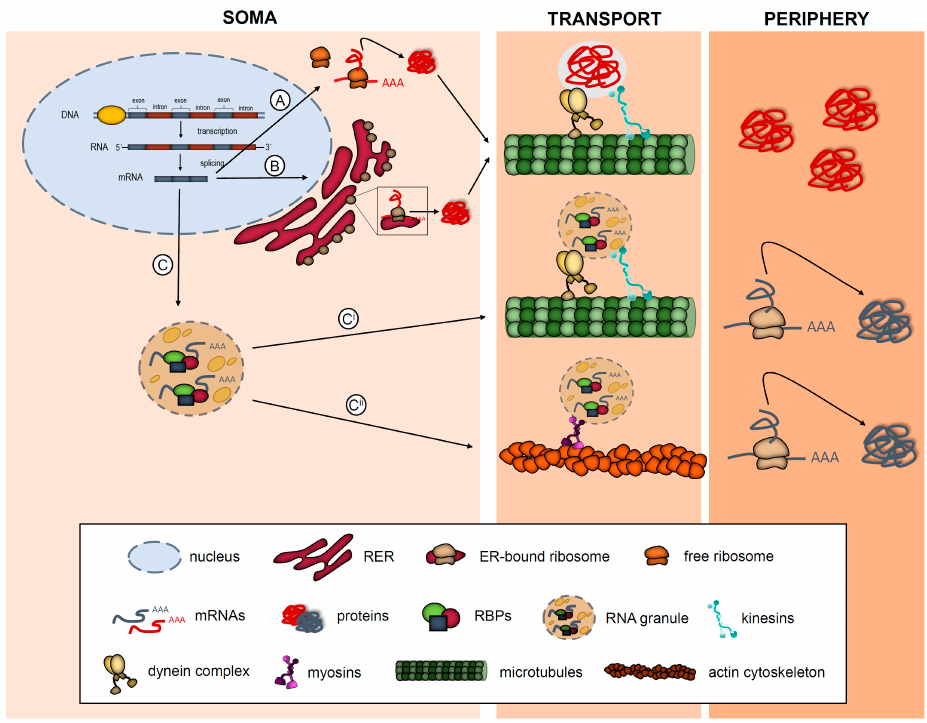
Figure 1. Simplified model of protein and mRNA trafficking in eukaryotic cells. Typically, proteins are thought to be synthesized in the soma by free ribosomes ( A ) or endoplasmic reticulum (ER)- bound ribosomes ( B ) and then transported to different destinations in the cells where they elicit their function. Some mRNAs associate to RNA-binding proteins (RBPs) and are transported in RNA granules ( C ) by microtubules using motor proteins kinesis and dynein ( C i ) or by actin using myosin ( C ii ). Once they reach the target compartment the mRNAs are translated into protein.